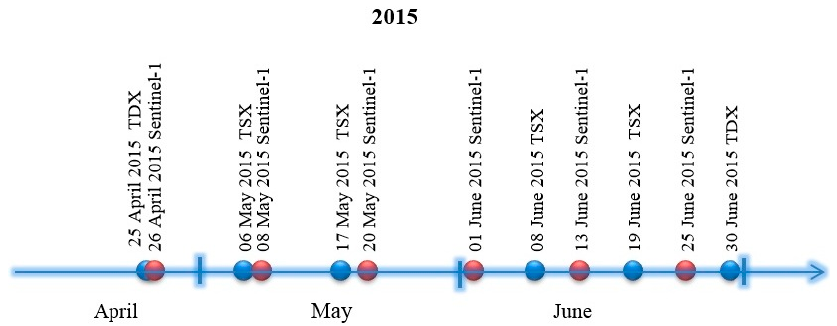
Figure 2. Satellite images used in the study.